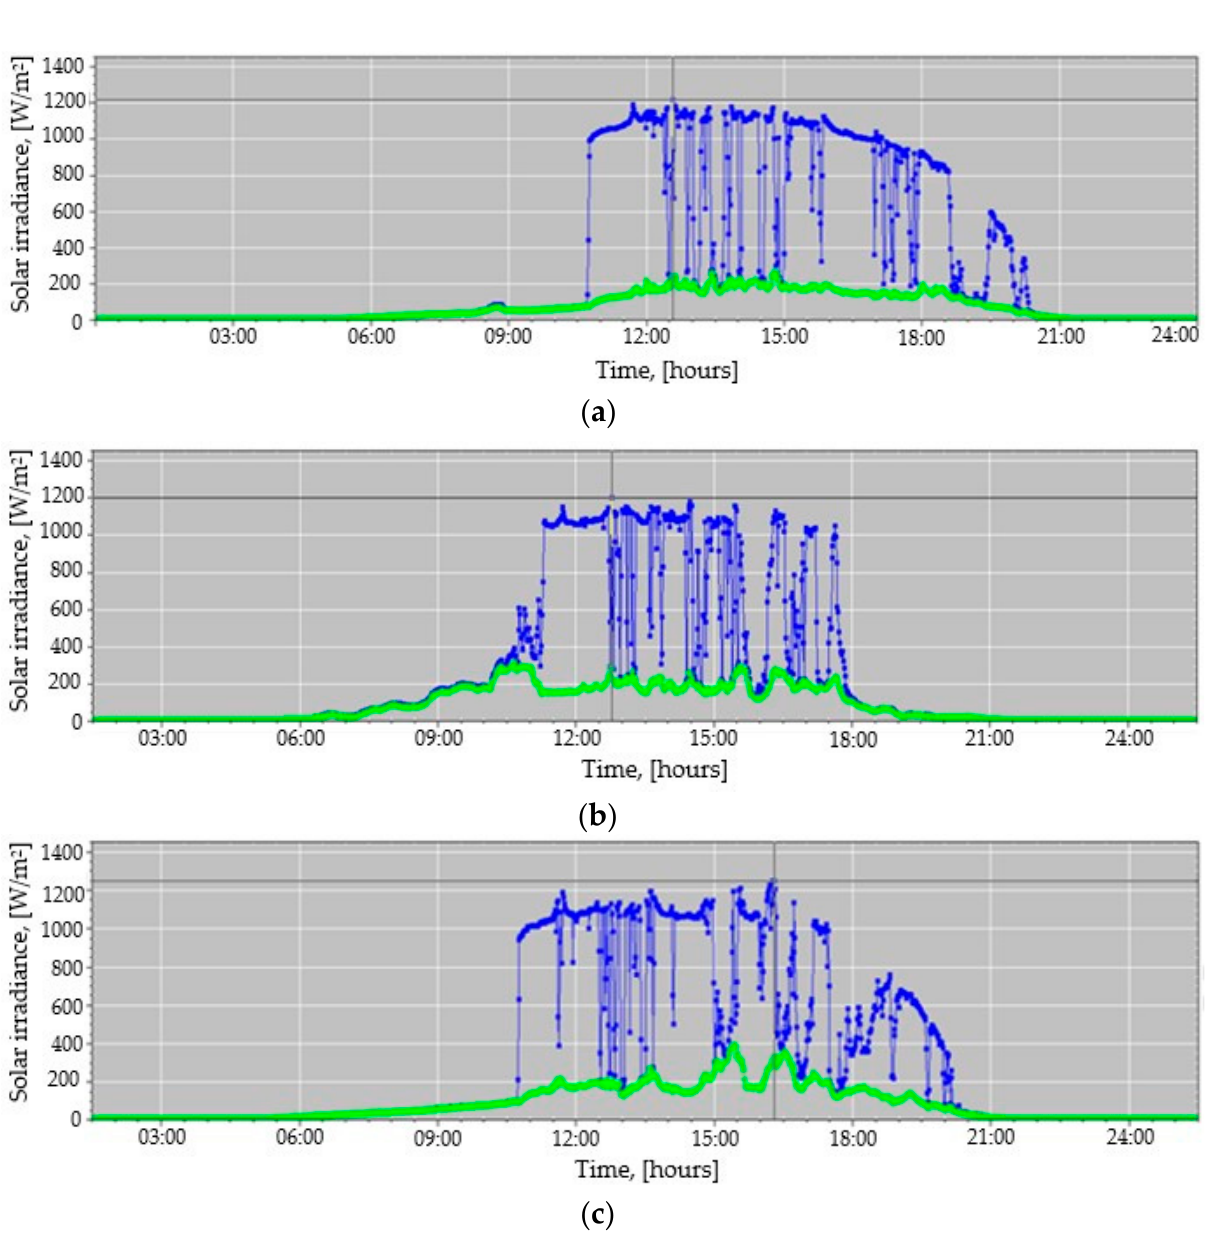
Figure 8. ( a ) Solar irradiance variations for 7 June 2022: ( – total component; – diffuse component). ( b ) Solar irradiance variations for 8 June 2022: ( – total component; – diffuse component). ( c ) Solar irradiance variations for 9 June 2022: ( – total component; – diffuse component). Table 2. The amount of energy used for consumption—first scenario. Energy Delivered